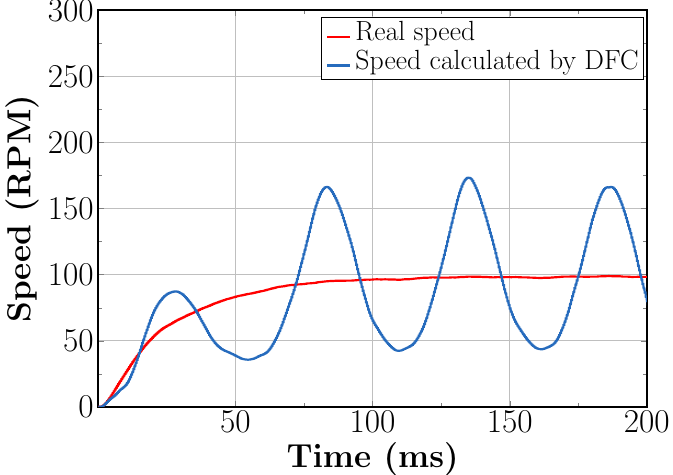
Figure 22. Sensorless speed control for 100 RPM, real speed of the machine and speed calculated by